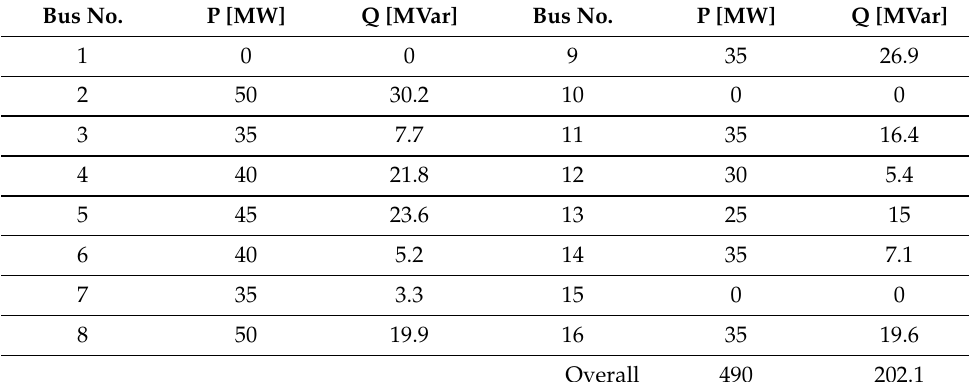
Table 2. List of load values for the respective system buses. Bus